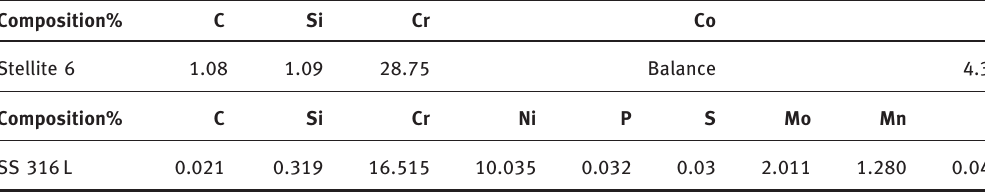
Table 1: Composition of base material and powder. Composition%